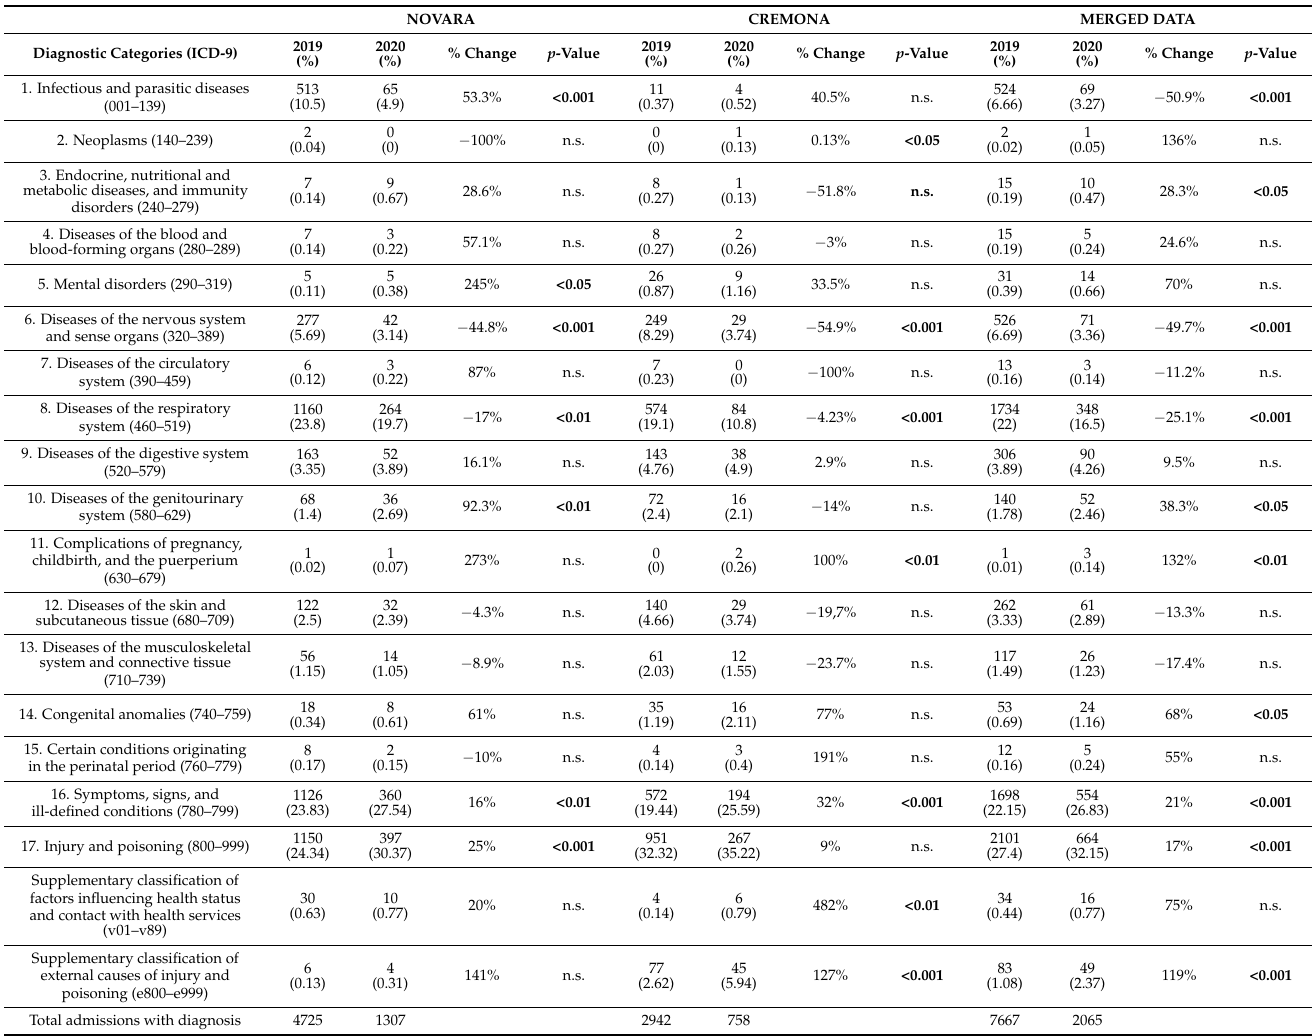
Table 2. Diagnoses for children under 15 years of age attending the Cremona and Novara pediatric EDs during the COVID-19 pandemic between 20 February 2020 and 2 June 2020 compared with the same period in 2019. Diagnoses are grouped according to the main ICD-9 diagnostic categories. Note: percentage changes are calculated from the percentages in each year rather than the absolute